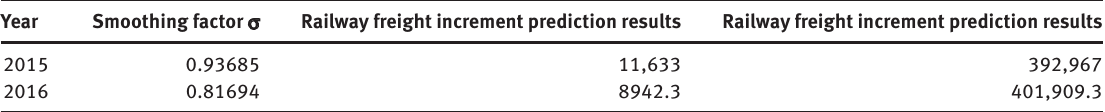
Table 4: Railway Freight Volume Forecast in 2015 and